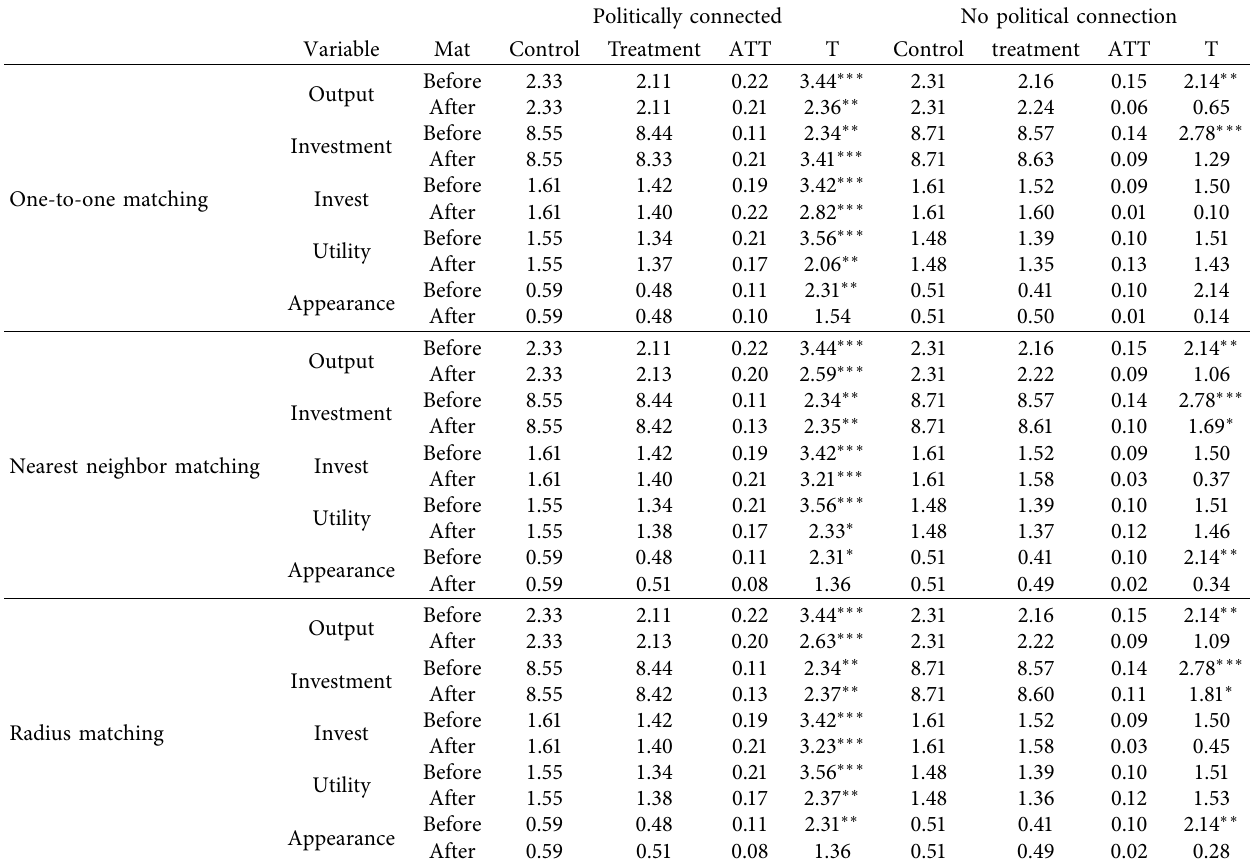
Table 8: Policy incentive effects under different political connections. Politically connected No political